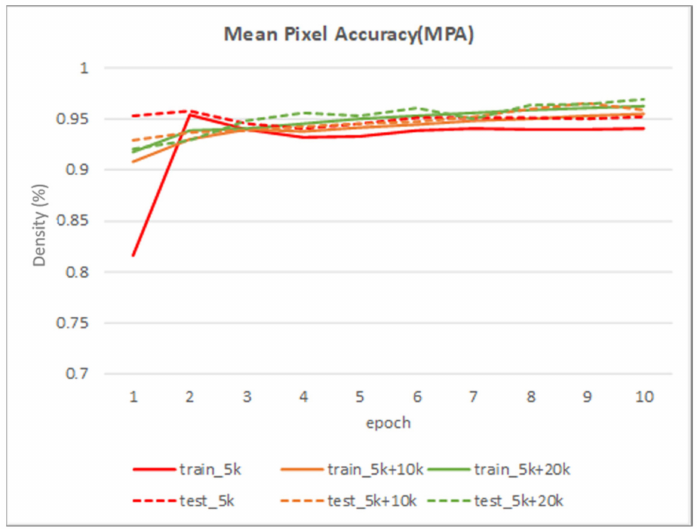
Figure 10. The mean pixel accuracy curve on training data and testing data.